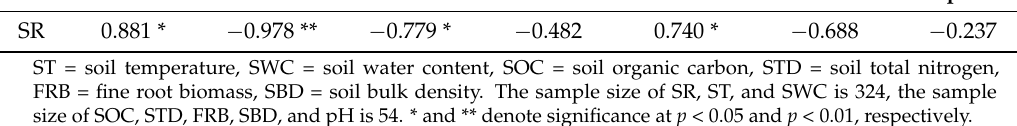
Table 4. Correlations between soil respiration (SR) and environmental factors. ST SWC SOC STD FRB SBD pH SR 0.881 * ´ 0.978 ** ´ 0.779 * ´ 0.482 0.740 * ´ 0.688 ´